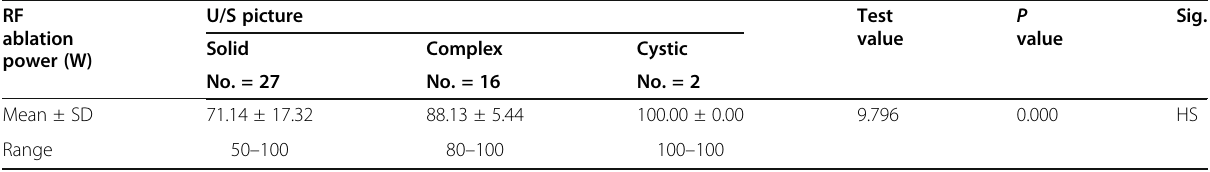
Table 4 The correlation between the texture of the thyroid nodule by US and the power of RF ablation RF U/S ablation power (W)